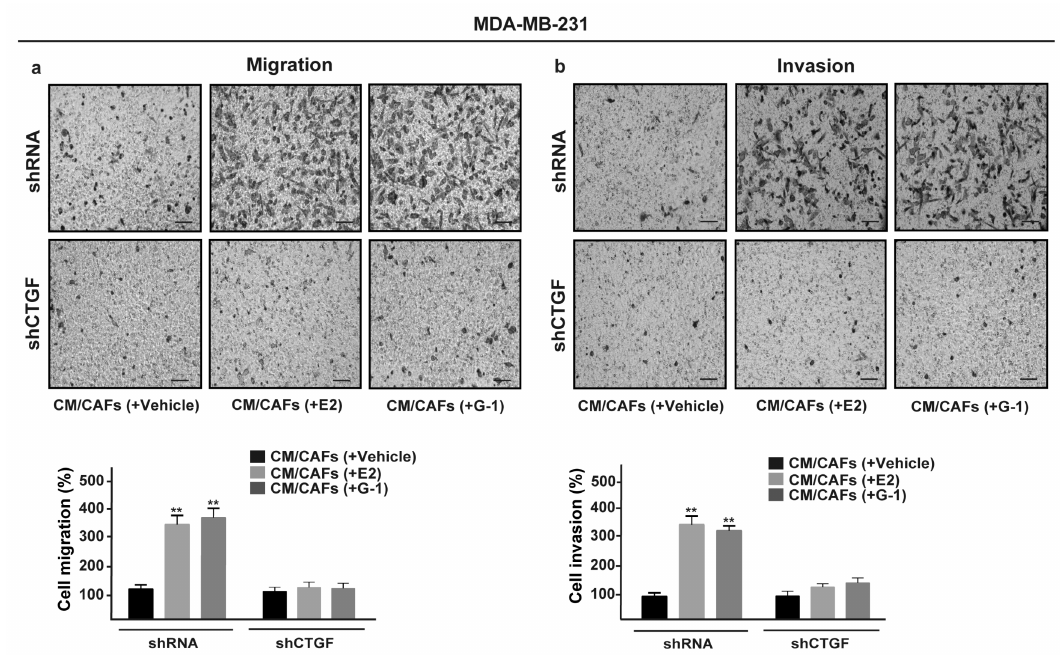
Figure 8. CTGF is required for migration and invasion induced by FGFR1 paracrine activation in MDA-MB-231 cells. Transwell assays were used to assess cell migration ( a ) and invasion ( b ) in MDA-MB-231 cells transfected for 24 h with control shRNA or shCTGF and then cultured for 8 h in CM from CAFs treated for 18 h with vehicle [CM/CAFs (+vehicle)], 10 nM E2 [CM/CAFs (+E2)] or 100 nM G-1 [CM/CAFs (+G-1)]. Cells were counted in at least 10 random fields at 10 × magnification, in three independent experiments performed in triplicate. Scale bar = 200 µ m, (**) indicates p <